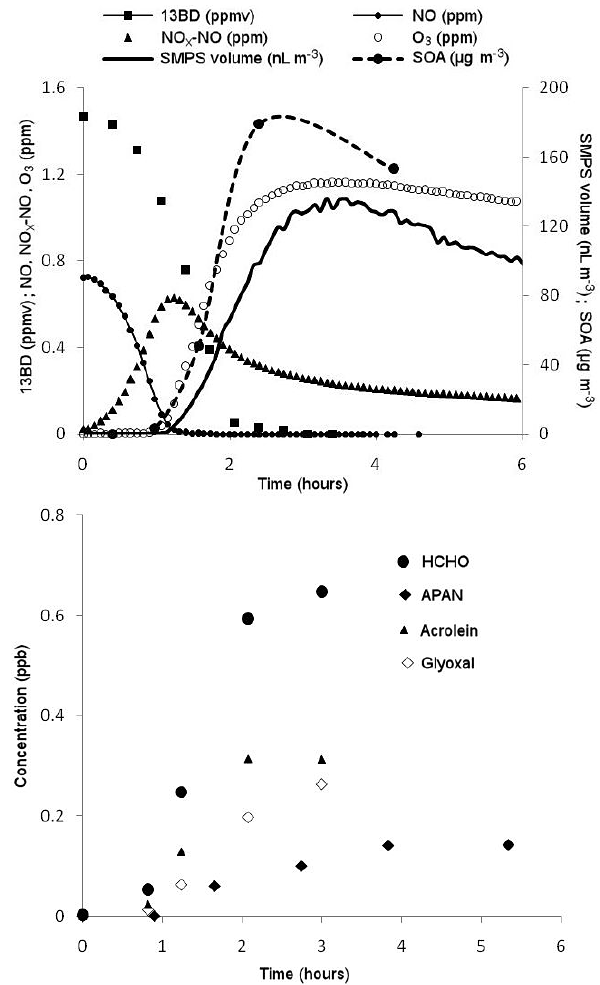
Figure 4. Time profile of gas-phase species from the oxidation of 13BD in experiment ER442. All species were corrected for